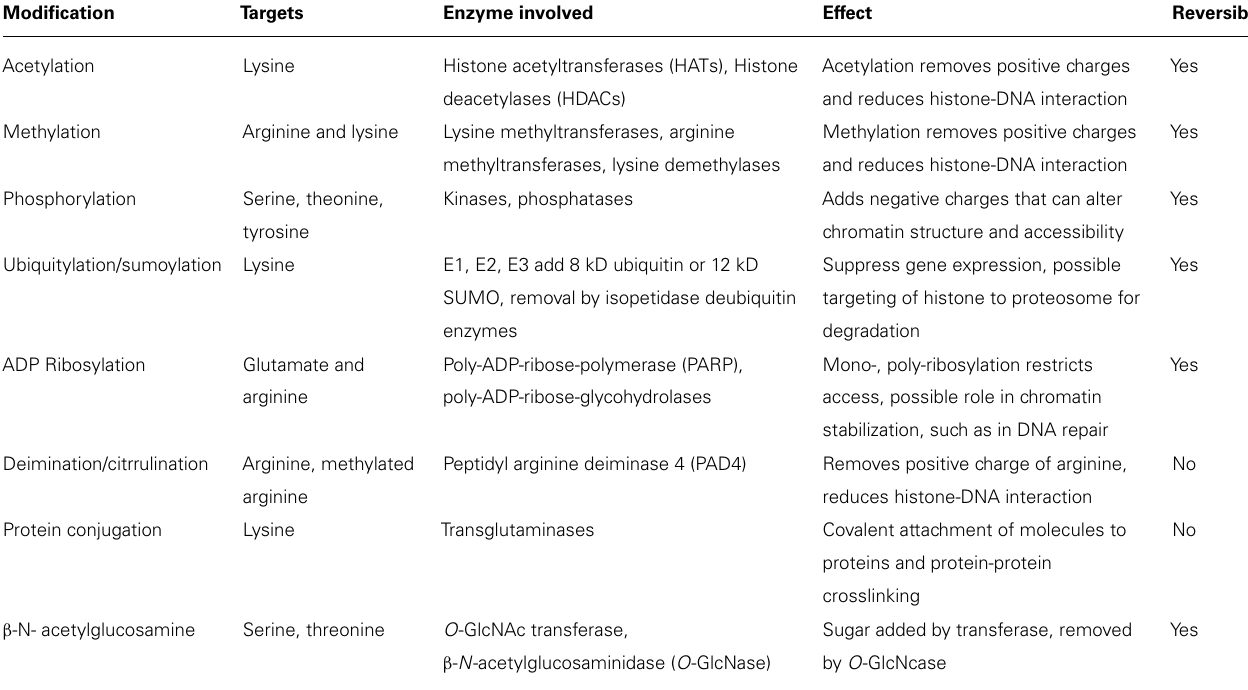
Table 1 | Histone modifications as part of epigenetic